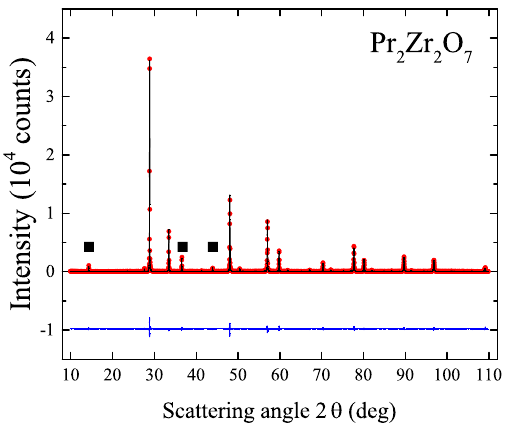
Figure 8. Room temperature powder X-ray diffraction pattern of a ground boule of Pr 2 Zr 2 O 7 prepared in air at a growth rate of 12.5 mm/h. The experimental profile (red closed circles) and a full profile matching refinement (black solid line) to the pyrochlore structure are shown, with the difference given by the blue solid line. ” (cid:110) ” indicate the low angle superlattice reflections of the pyrochlore